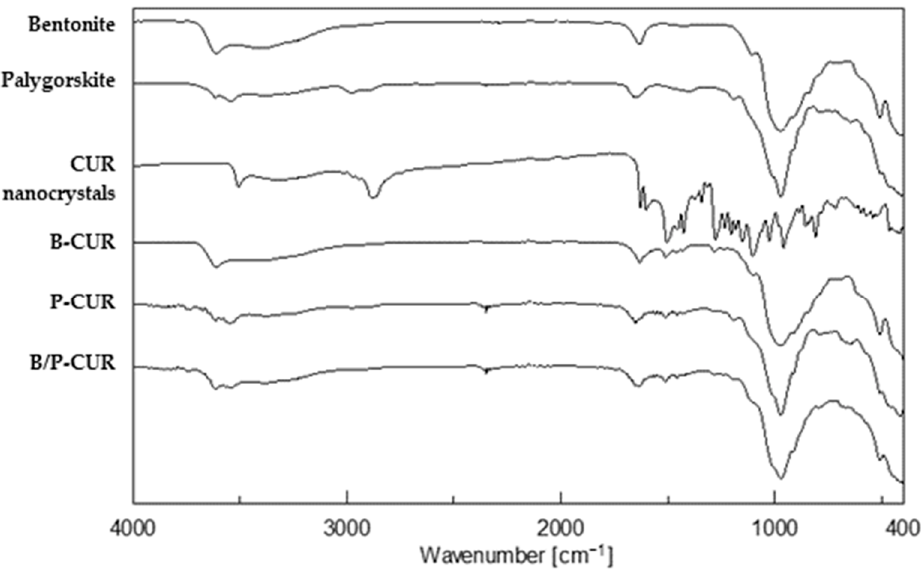
Figure 5. FTIR spectra of the pure components (bentonite, palygorskite, and curcumin nanocrystals) and hydrogels (B-CUR, P-CUR, and B/P-CUR).